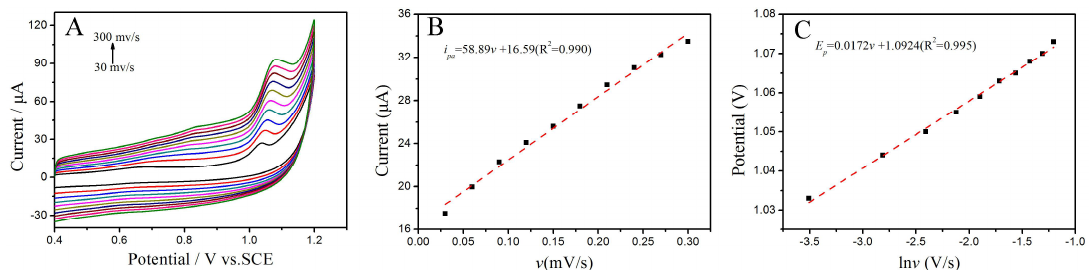
Figure 6. ( A ) CVs of 1.0 × 10 −5 mol/L tartrazine on the TiO 2 –ErGO–GCE at different scan rates; ( B ) Relationship between oxidation peak current and scan rate; ( C ) Relationship between peak potential and the Napierian logarithm of the scan rate. Saturated calomel electrode (SCE).